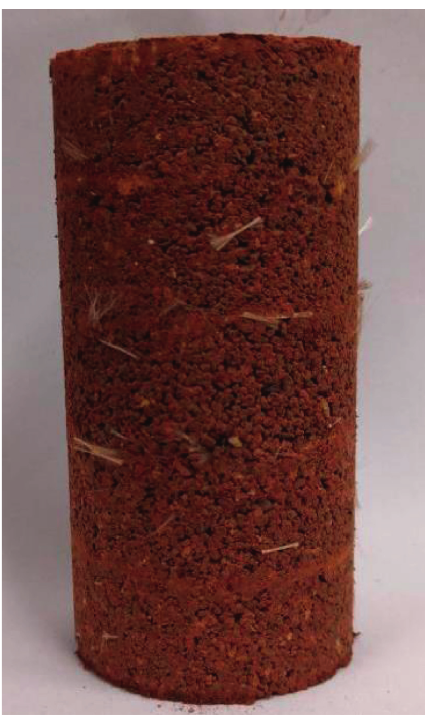
Figure 5: Photograph showing the specimens.